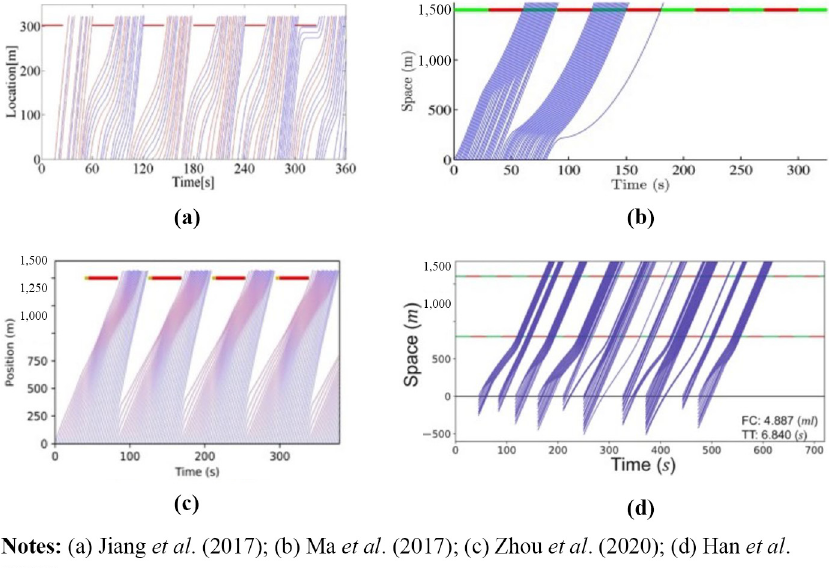
Figure 2 Examples for CAV trajectory planning results at isolated intersections